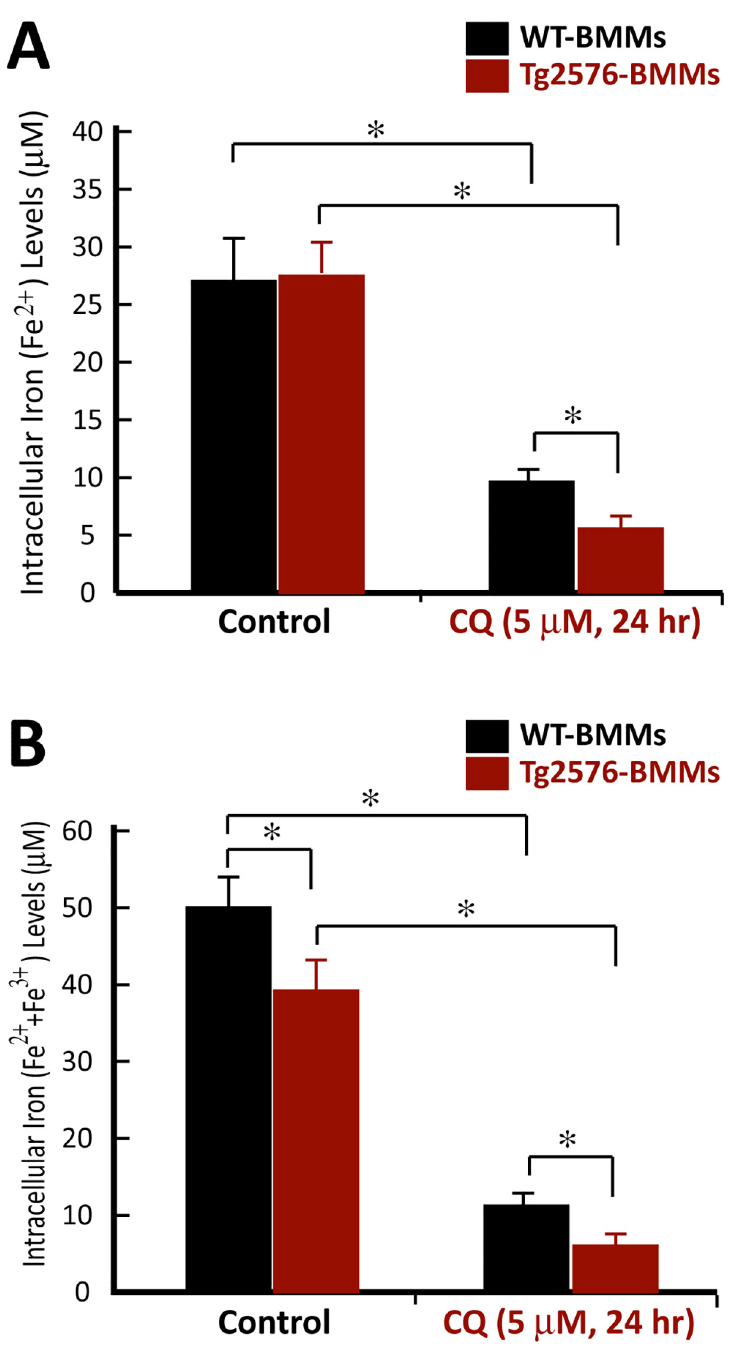
Fig 7. CQ reduction of intracellular iron levels in WT- and Tg2576-BMMs in vitro. BMMs from WT- and Tg2576 mice were incubated in the absence or presence of 5-microM CQ for 24 hours. Cells were harvested, and the intracellular total Fe2+ and Fe3+ concentrations were determined by Iron colorimetric assay (see Methods). The values of mean ± SD from 3 separate assays were shown. * , P < 0.05, significant